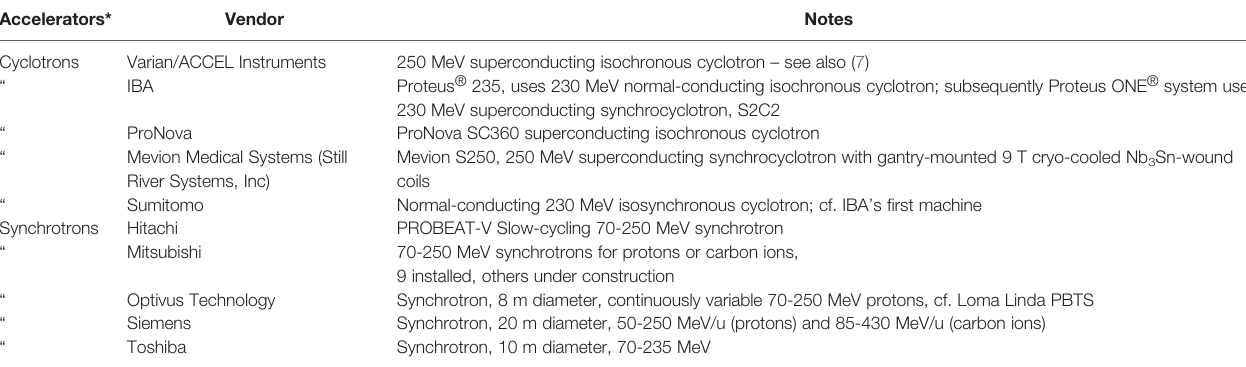
TABLE 7 | Accelerators for proton and/or carbon-Ion therapy – some commercial